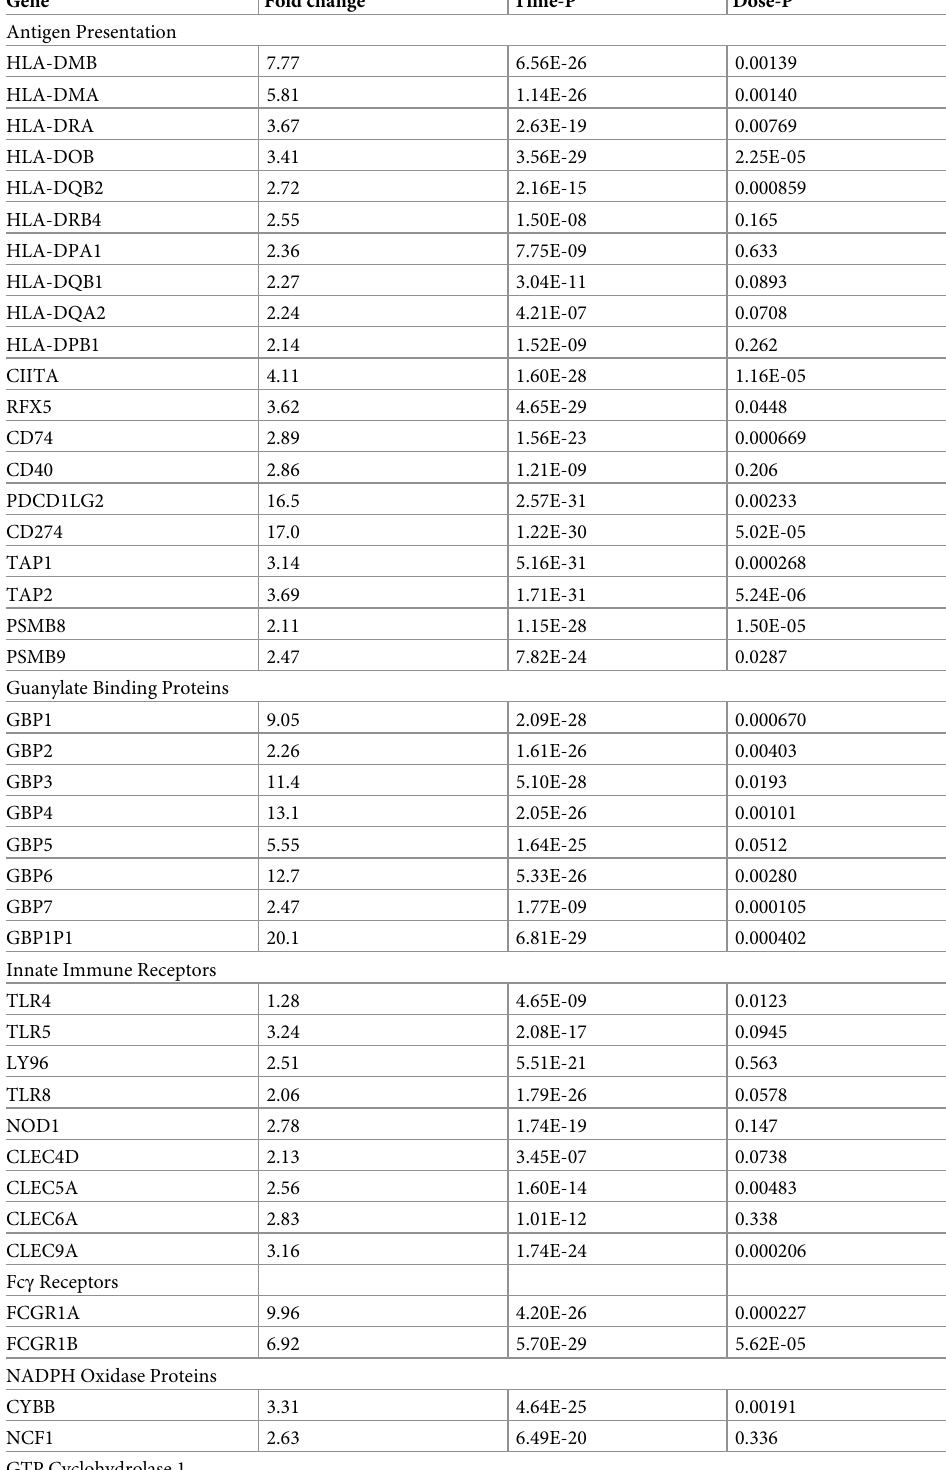
Table 1. Functionally relevant neutrophil genes that were altered by IFN- γ administration to healthy subjects.